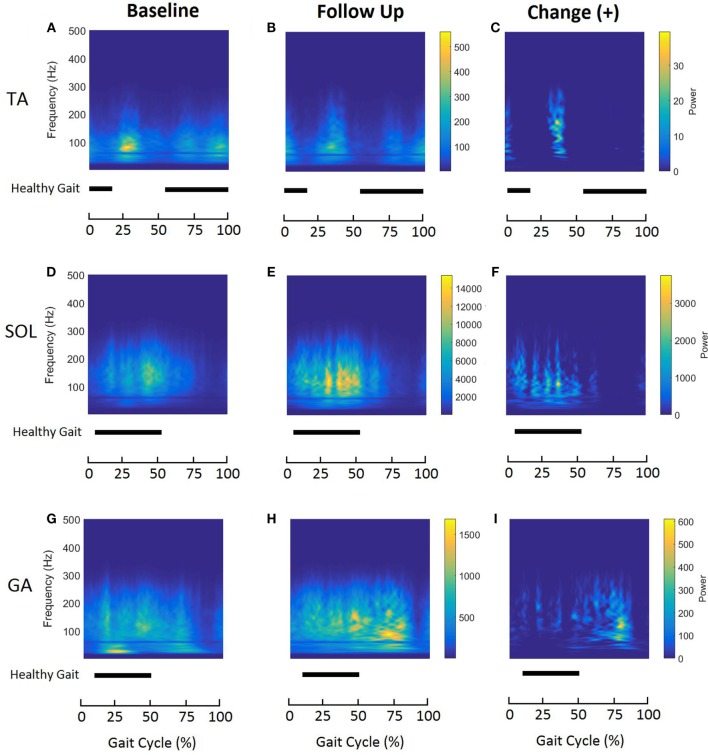
Averaged time–frequency representations of affected tibialis anterior (A–C), soleus (D–F), and gastrocnemius (G–I) muscles during normalized gait at baseline (left column) and follow-up (middle column) for all participants (n = 6). The right column represents the positive changes in the distributions after follow-up. Energy levels are presented as a color bar for each muscle. Horizontal bars indicate activation (ON–OFF) for the same muscle during normalized healthy gait, reported by Perry and Burnfield (22).